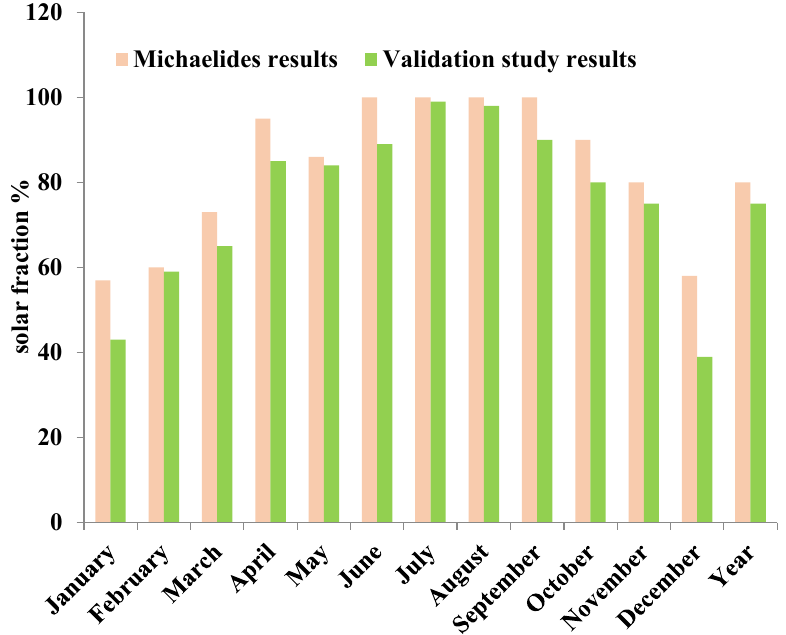
Figure 12. Solar fraction of Michaelides study versus validation study.